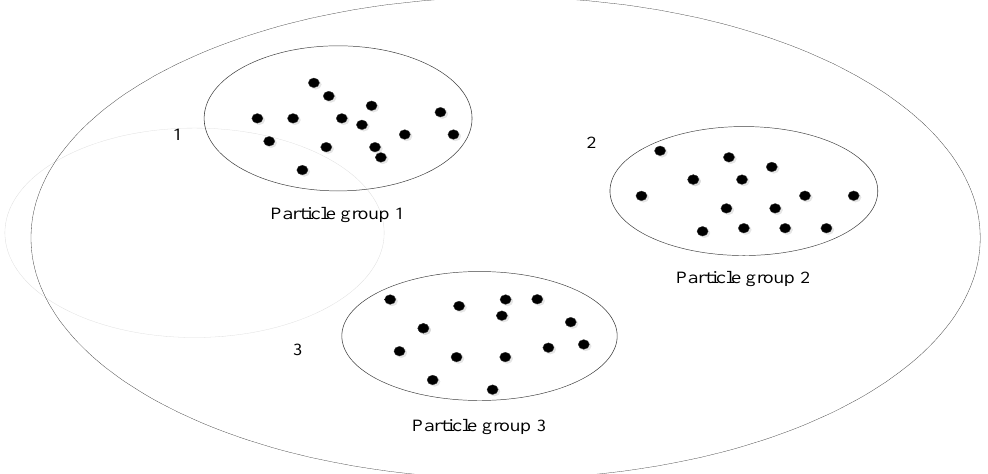
Figure 10. Multiple groups of particle searching in the solution space.